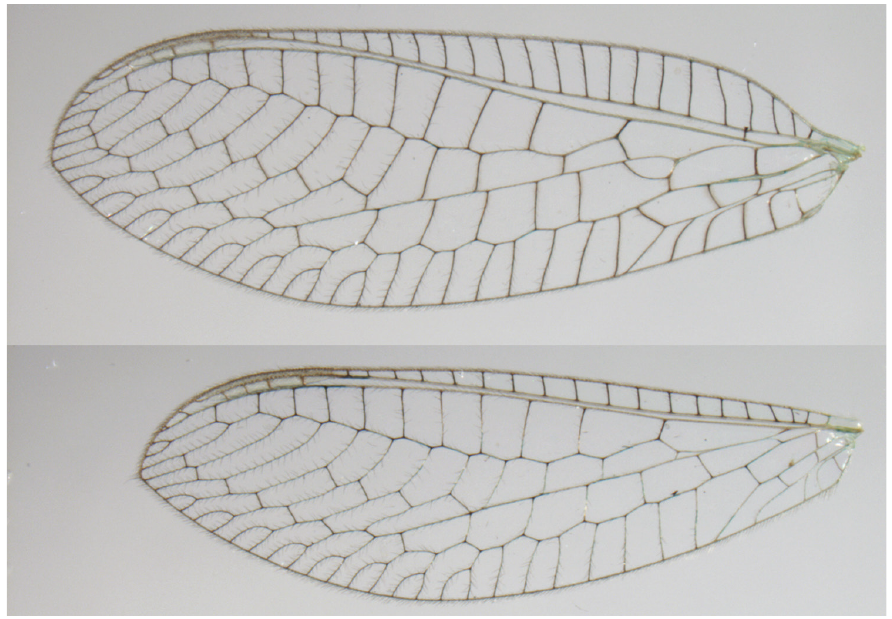
Figure 65. Ungla nigromaculifrons Sosa: Wings (Venezuela, Táchira, female, UMSP).